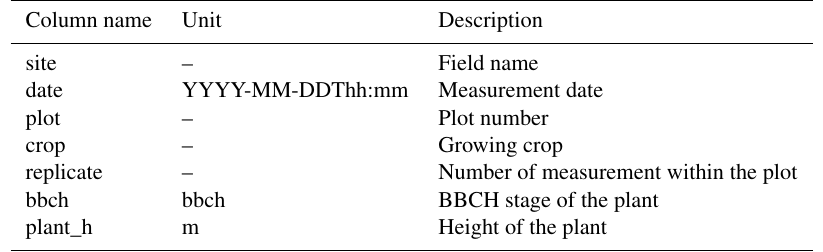
Table 17. Determined plant development stage and height measurement and data description (phenology.csv).